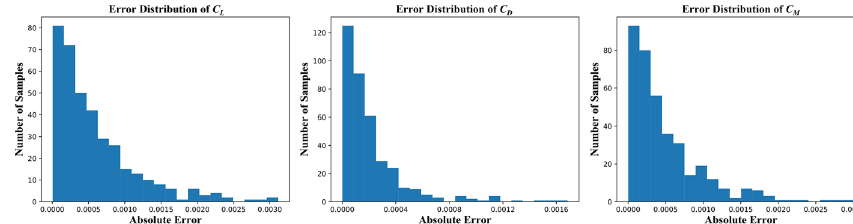
Fig. 21 Absolute error distribution of the CNN prediction for C L , C D , and C